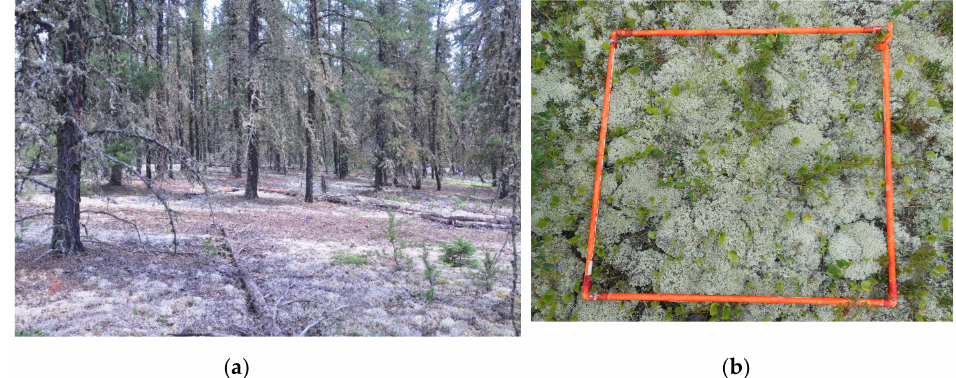
Figure 2. Terricolous lichen-dominated understory of a lichen woodland ecosystem in Alberta, Canada. ( a ) The study area consists primarily of mature ( > 90 years old) jack pine ( Pinus banksiana ) with a lichen-dominated understory. ( b ) Cover of lichen was visually estimated in 1 m 2